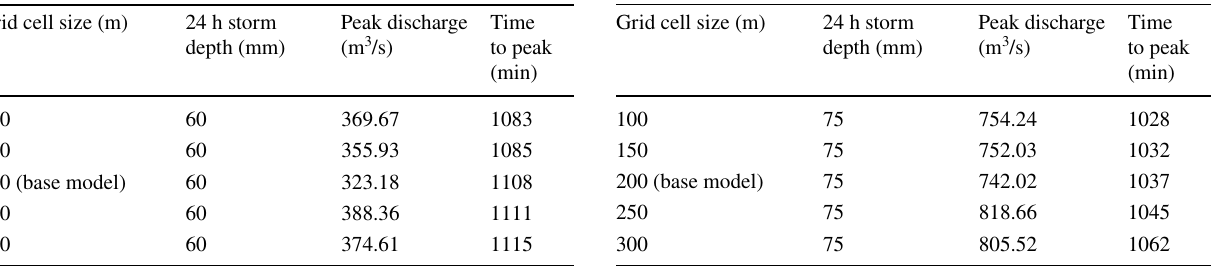
Table 8 Flood properties of calibrated GSSHA base model for a 24-h, 60 mm storm flood compared to hydrographs corresponding to GSSHA models with cell sizes of 100–300 m